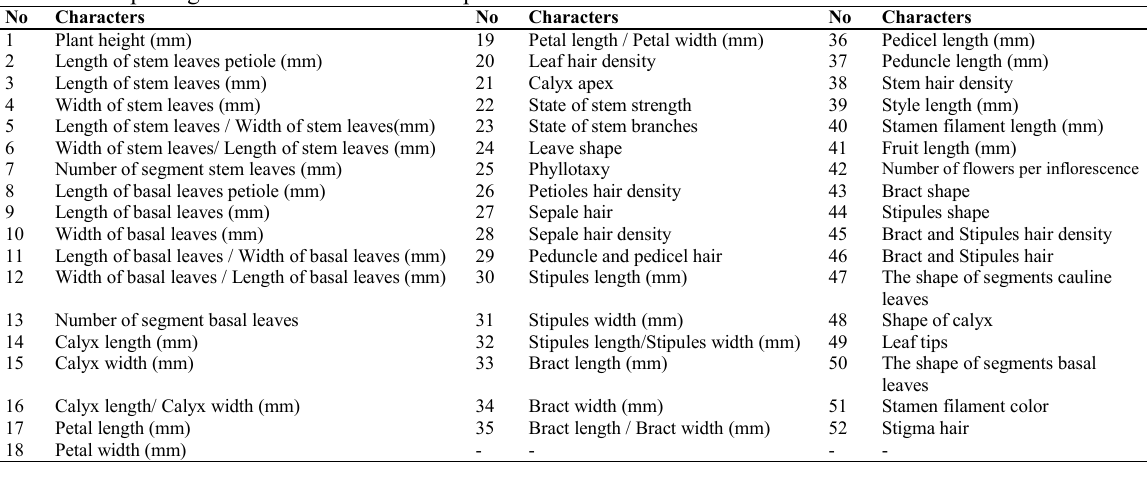
Table 2. Morphological characters in studied species.